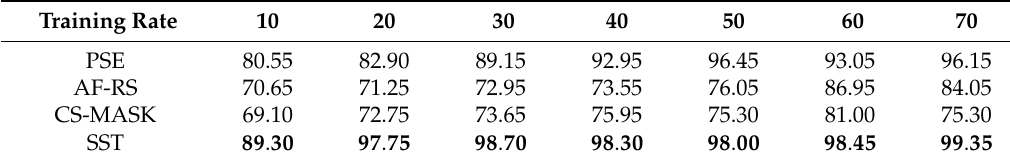
Table 5. Recognition rate for